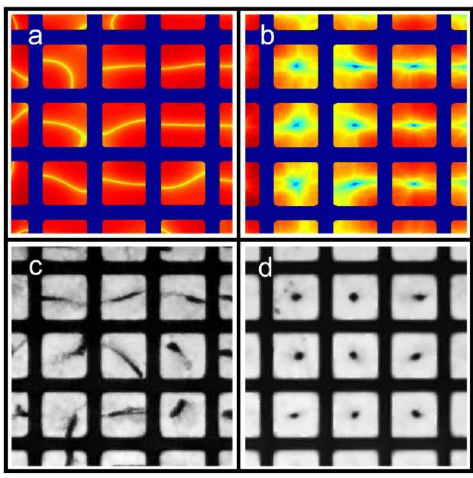
Figure 3. Comparison between modeling ( a , b ) and experiments ( c , d ) for the wedge-transducer device. Simulation of the time-averaged pressure squared ( p 2 ) for single-frequency actuation at 2.60 MHz ( a ) and for the average of 50 single frequencies between 2.55 and 2.65 MHz ( b ). Both plots are normalized individually and shown in logarithmic scale. The predicted trapping locations ( i.e ., the minima of p 2 ) are indicated in yellow (in a ) and in dark blue (in b ). Experimental confirmation of the simulations using 5 µm particles at single-frequency actuation ( c ) and with frequency-modulated actuation ( d ) using the same frequency intervals as ( a ) and ( b ). Scale bar is indicated by the wells (300 µm wide squares).The figure is reproduced from Ref. [16] with permission from RSC.